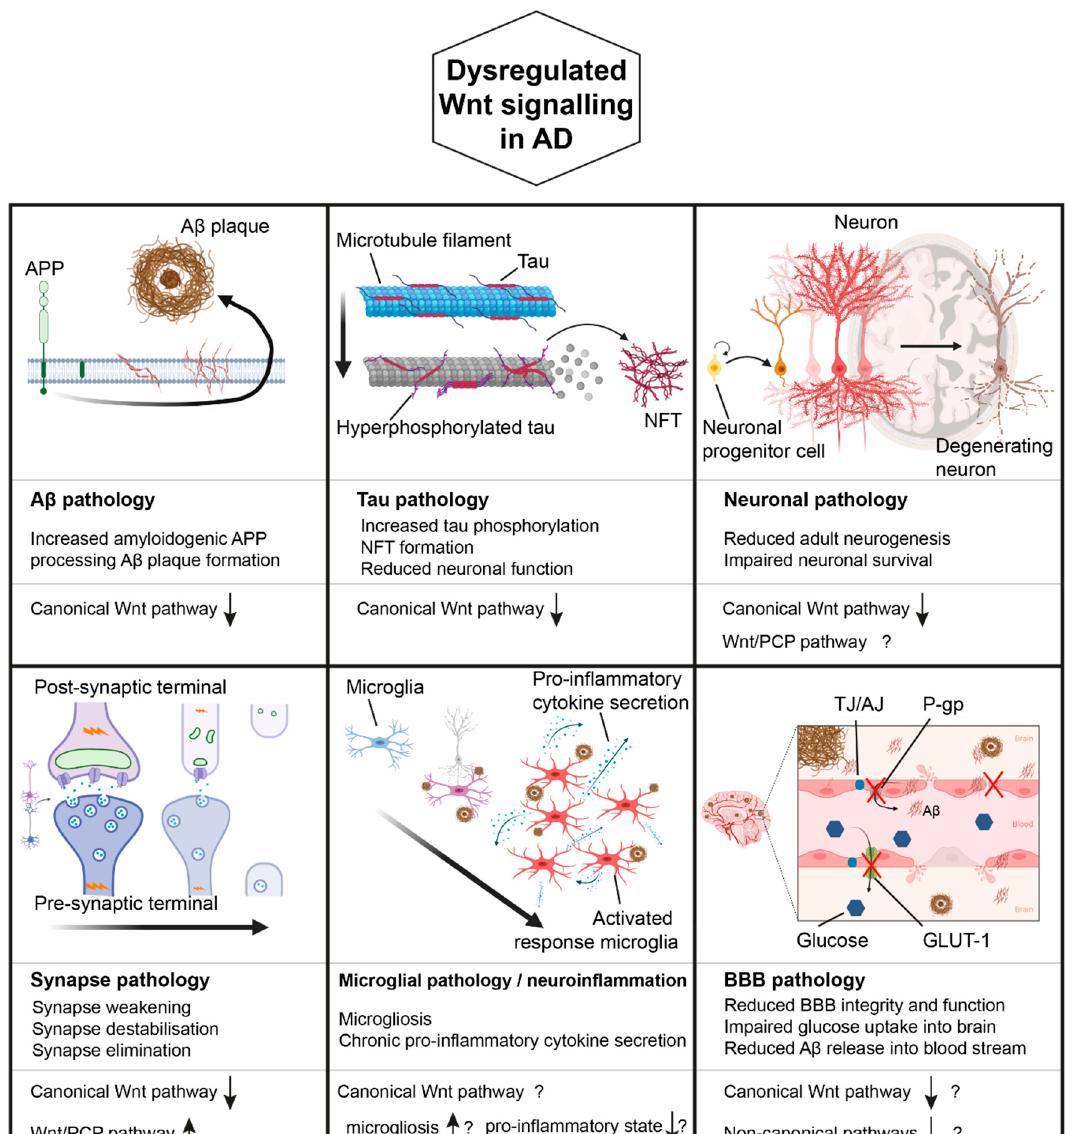
Figure 2. Wnt signalling in AD. Dysregulated Wnt signalling may contribute to various pathological manifestation of AD, including A β pathology, Tau pathology, neuronal pathology, synapse pathology, microglial pathology / neuroinflammation, as well as BBB pathology. Known or hypothesised (indicated by ‘?’) changes in Wnt signalling associated with each manifestation are indicated (based on published literature). ↑ and ↓ indicate increased and decreased Wnt signalling respectively. Created with Biorender.com.